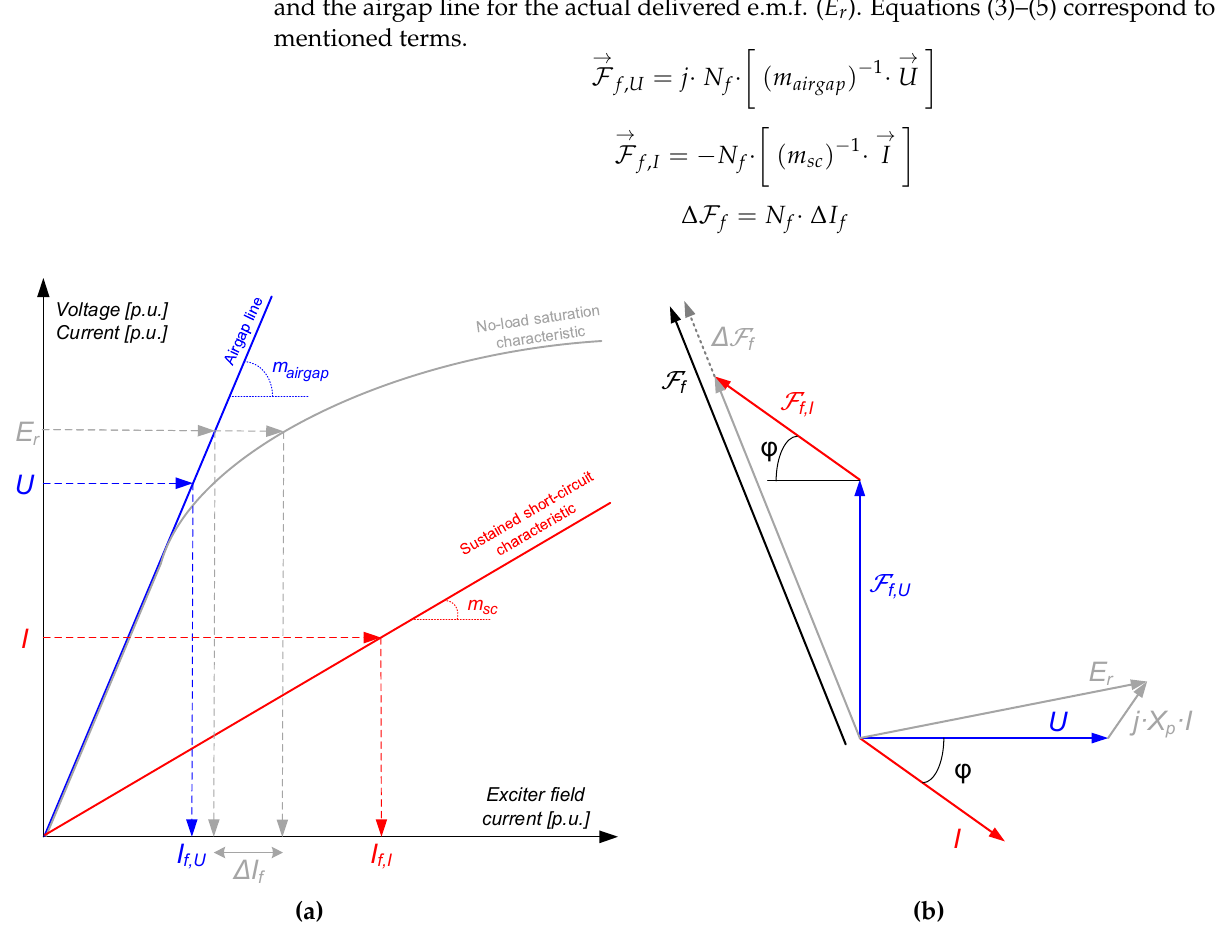
Figure 2. Main machine field current excitation model construction through the ASA method: ( a ) Equivalent exciter field current components determination; ( b ) Phasor diagram.